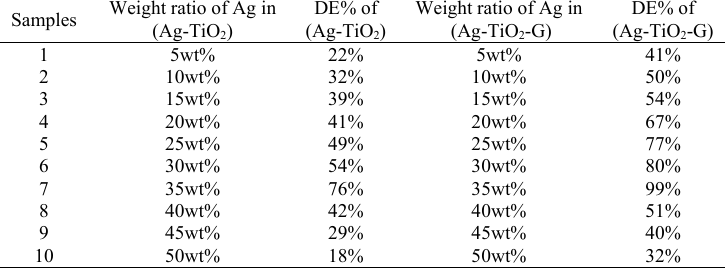
Table 1. Investigation the effect of graphene in degradation efficiency of